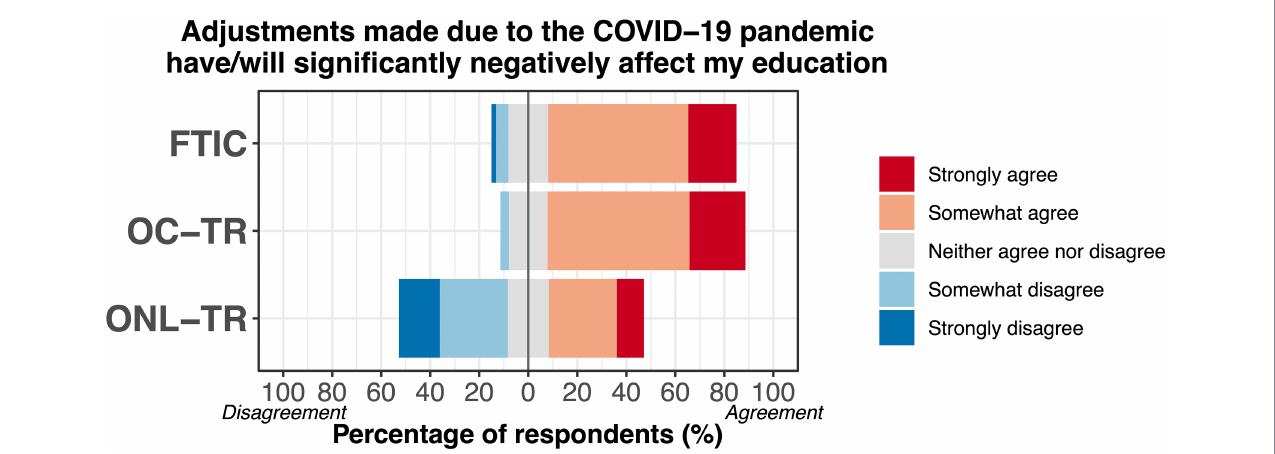
FIGURE 1 Percentage of unique student responses by student type to the negative educational impact question. Students responded on a five-point Likert scale ranging from Strongly Disagree to Strongly Agree, where any level of disagreement with the statement is represented with shades of blue and any level of agreement in shades of red. Each bar represents all (100%) unique student respondents for a given student type, where neutral responses (gray) are centered at 0 (central, vertical line). Multiple responses from the same student were averaged so that percentages represent unique students, not total